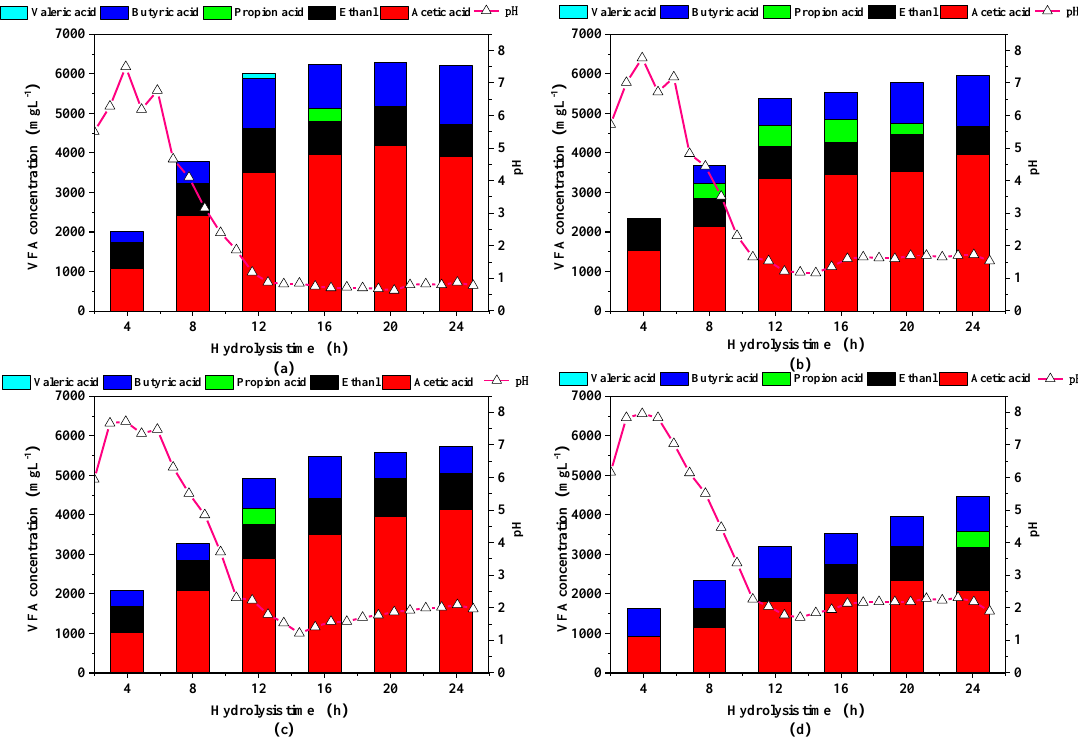
Figure 4. Volatile fatty acids (VFAs) concentrations and pH of rice straw with different particle sizes in aerobic hydrolysis and acidification step. Notes: ( a – d ) are sieve size diameter of 1,3,5,7 mm, respectively. and acidification step. Notes: ( a – d ) are sieve size diameter of 1, 3, 5, 7 mm,